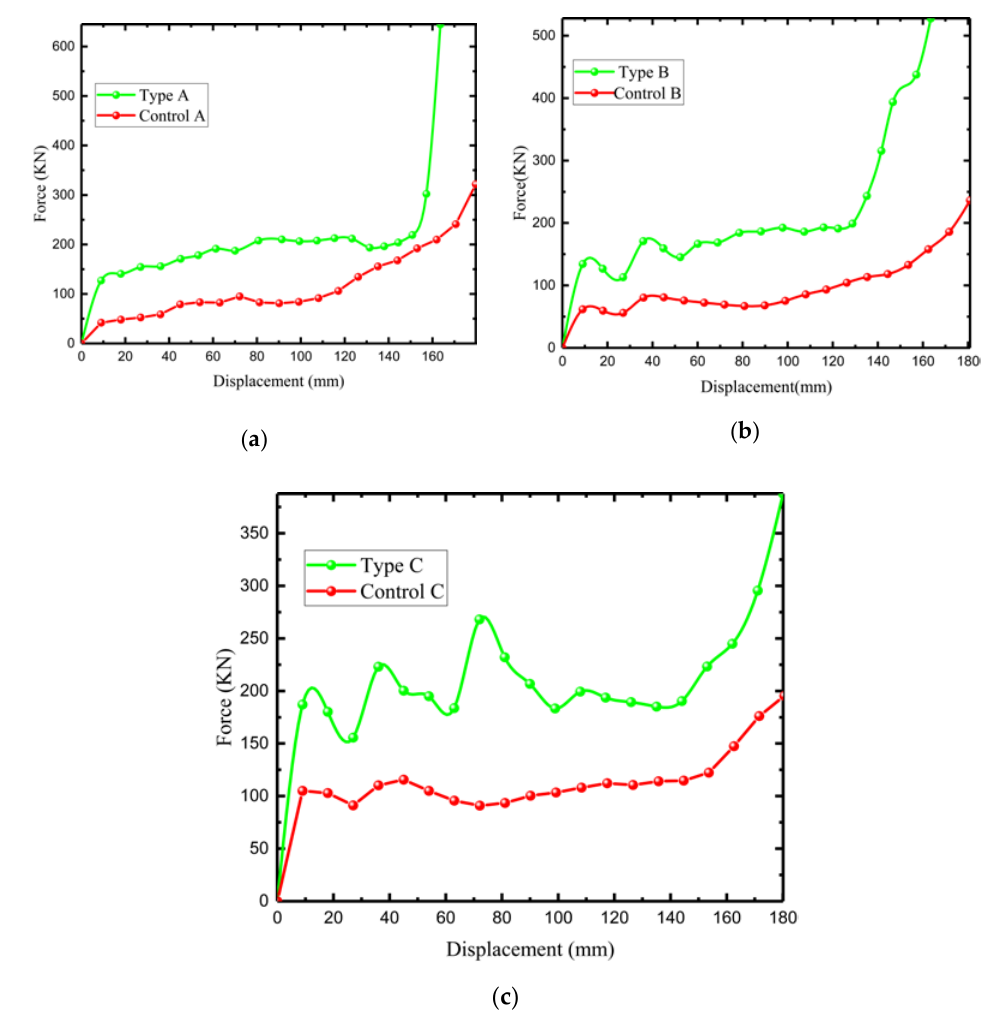
Figure 15. Three types of load–displacement curves. ( a ) Comparative load–displacement curve of type A; ( b ) Comparative load–displacement curve of type B; ( c ) Comparative load–displacement curve of type C.